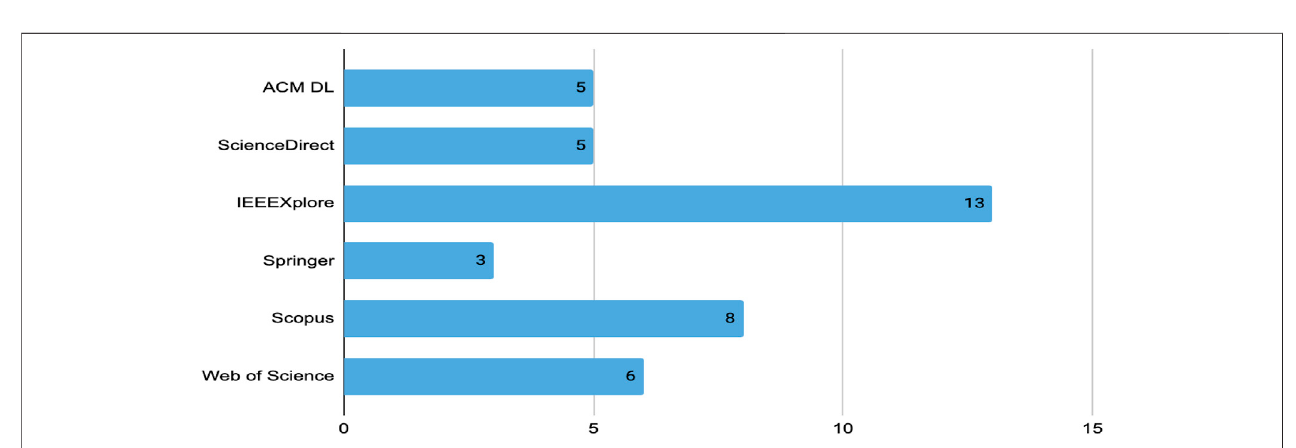
FIGURE 3 | Distribution of studies in academic